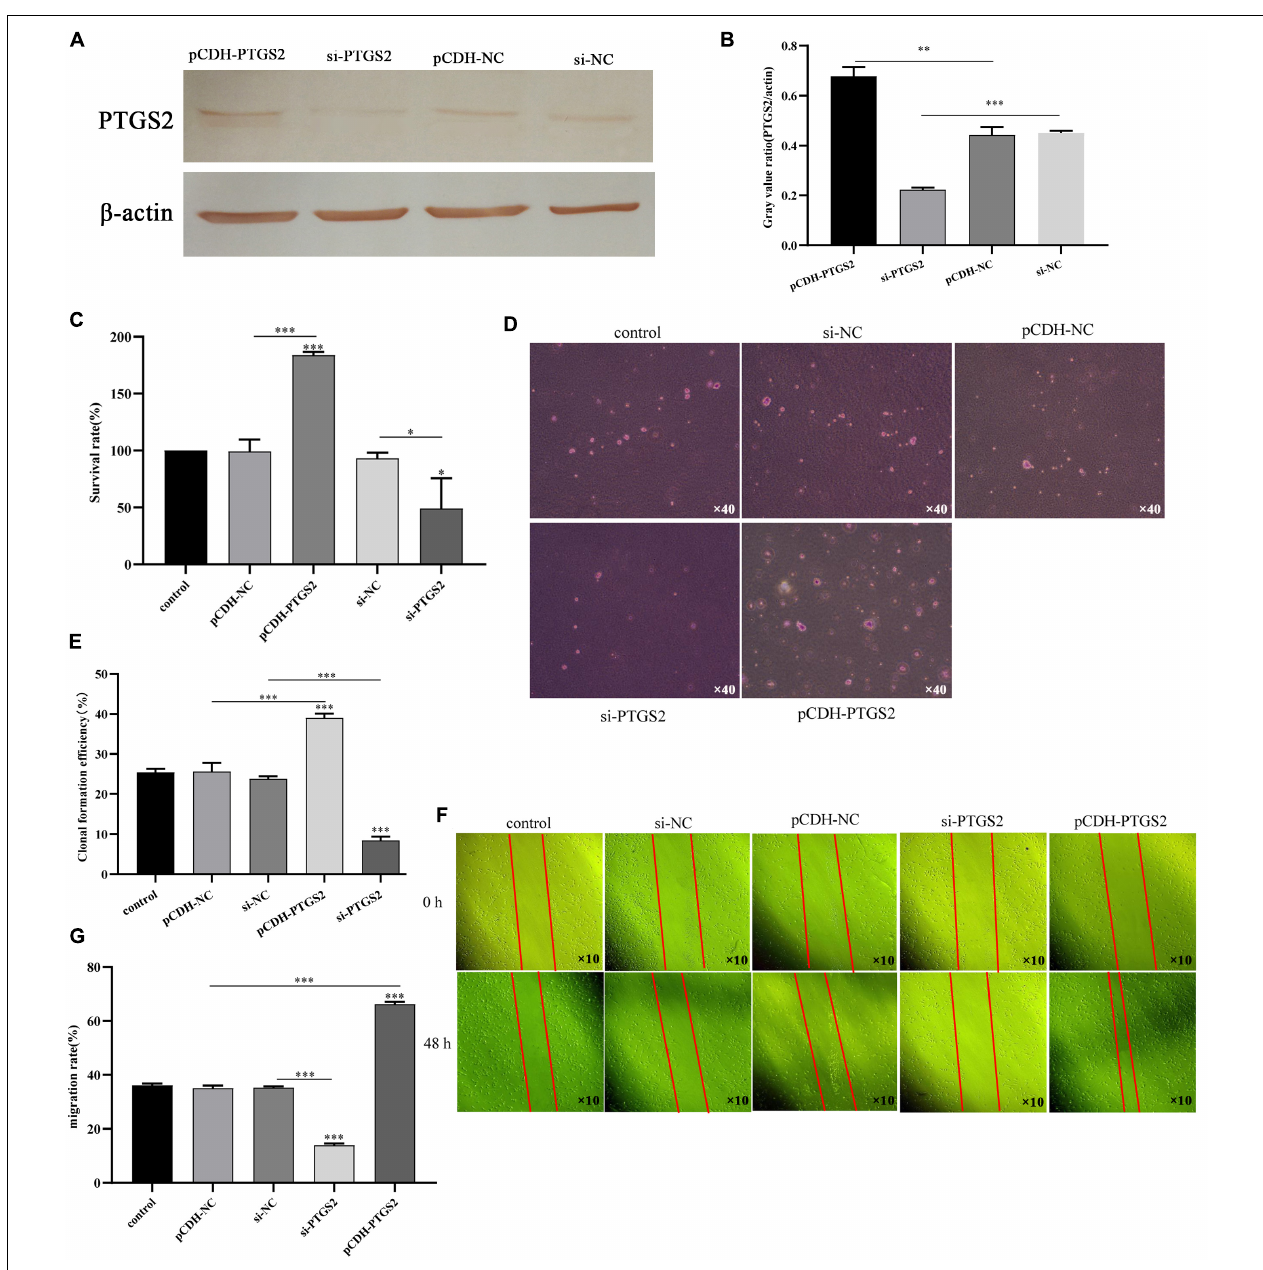
FIGURE 7 | (A,B) The transfection efficiency of pCDH-PTGS2 and si-PTGS2 was detected by western blot. (C) The effects of PTGS2 knockdown or overexpression on the vitality of AD model cells (A β 25 − 35 -treated SH-SY5Y cells) measured using the CCK-8 assay. (D,E) The effects of PTGS2 knockdown or overexpression on the proliferation of AD model cells (A β 25 − 35 -treated SH-SY5Y cells) measured using the soft agar assay. Scales: 10 × 40. (F,G) The effects of PTGS2 knockdown or overexpression on the migration of AD model cells (A β 25 − 35 -treated SH-SY5Y cells) measured using the wound healing assay. Scales: 10 × 10. The data are shown as the mean ± standard deviation. The horizontal line indicates the comparison between groups at both ends, and the non-horizontal line indicates the comparison with the control group. AD: Alzheimer’s disease. ∗∗∗ p < 0.001; ∗∗ p < 0.01; ∗ p <